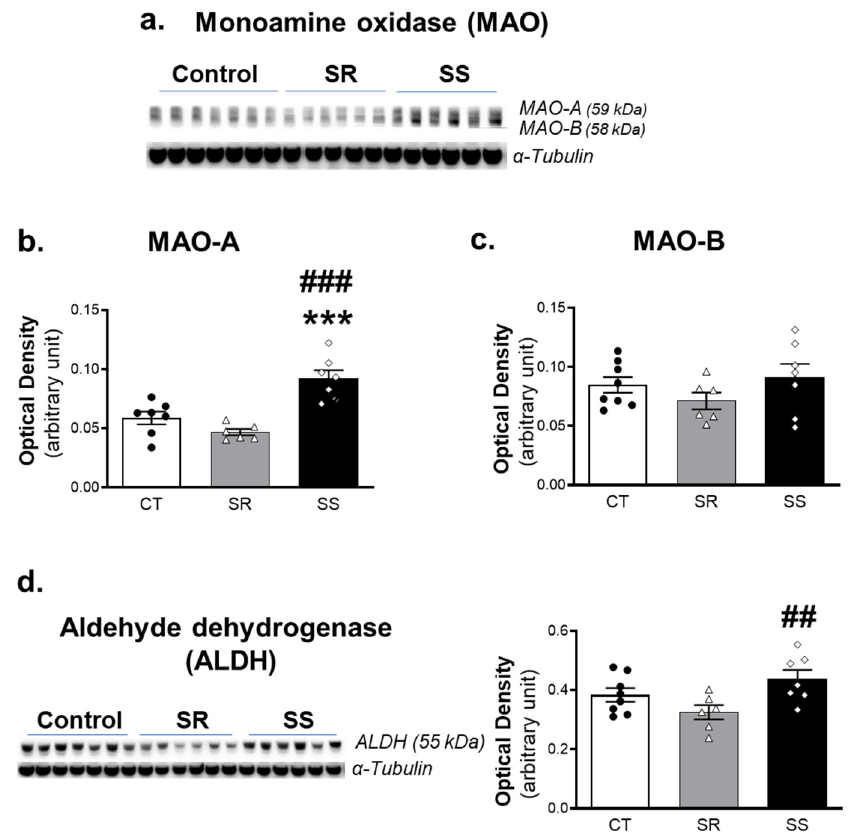
Figure 4. Protein levels of DA metabolizing enzymes. ( a ) Immunoblot analysis of MAO following withdrawal from METH self-administration. The anti-MAO antibody detected both MAO-A (59 kDa) and MAO-B (58 kDa). ( b ) Shock-sensitive rats exhibited higher levels of the MAO-A protein. ( c ) There were no differences in MAO-B levels between the three groups. ( d ) Western blot analysis of the ALDH enzyme in SR, SS, and control rats. ALDH protein levels were higher in the SS rats in comparison to SR rats. For quantification, the protein levels of MAO-A, MAO-B and ALDH were normalized to α -tubulin and then analyzed. Key to statistics: *** p < 0.001, comparison SR and SS vs. CT group; ## p < 0.01, ### p < 0.001, comparison between SR and SS groups. All values represent means ± SEM. CT (n = 8), control saline rats; SR (n = 7), shock-resistant, vulnerable, compulsive METH takers;